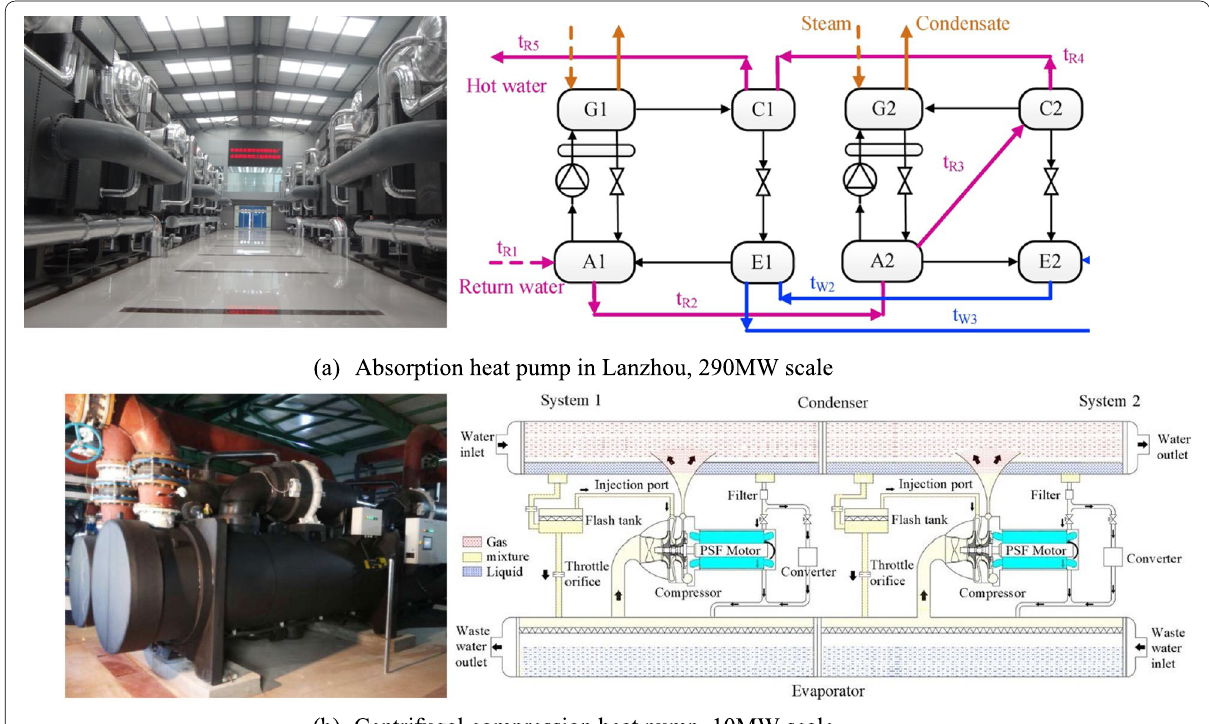
Fig. 3 Waste-heat-based heat pumps for district heating. a Absorption heat pump in Lanzhou, 290 MW scale. b Centrifugal compression heat pump, 10 MW